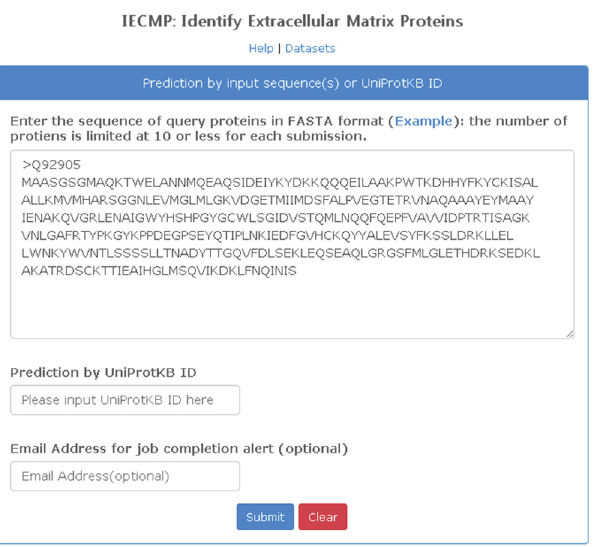
Fig 6. The main page of the IECMP web-server. Users can either enter the sequence of query proteins in FASTA format or input the UniProtKB ID of the query protein for prediction.